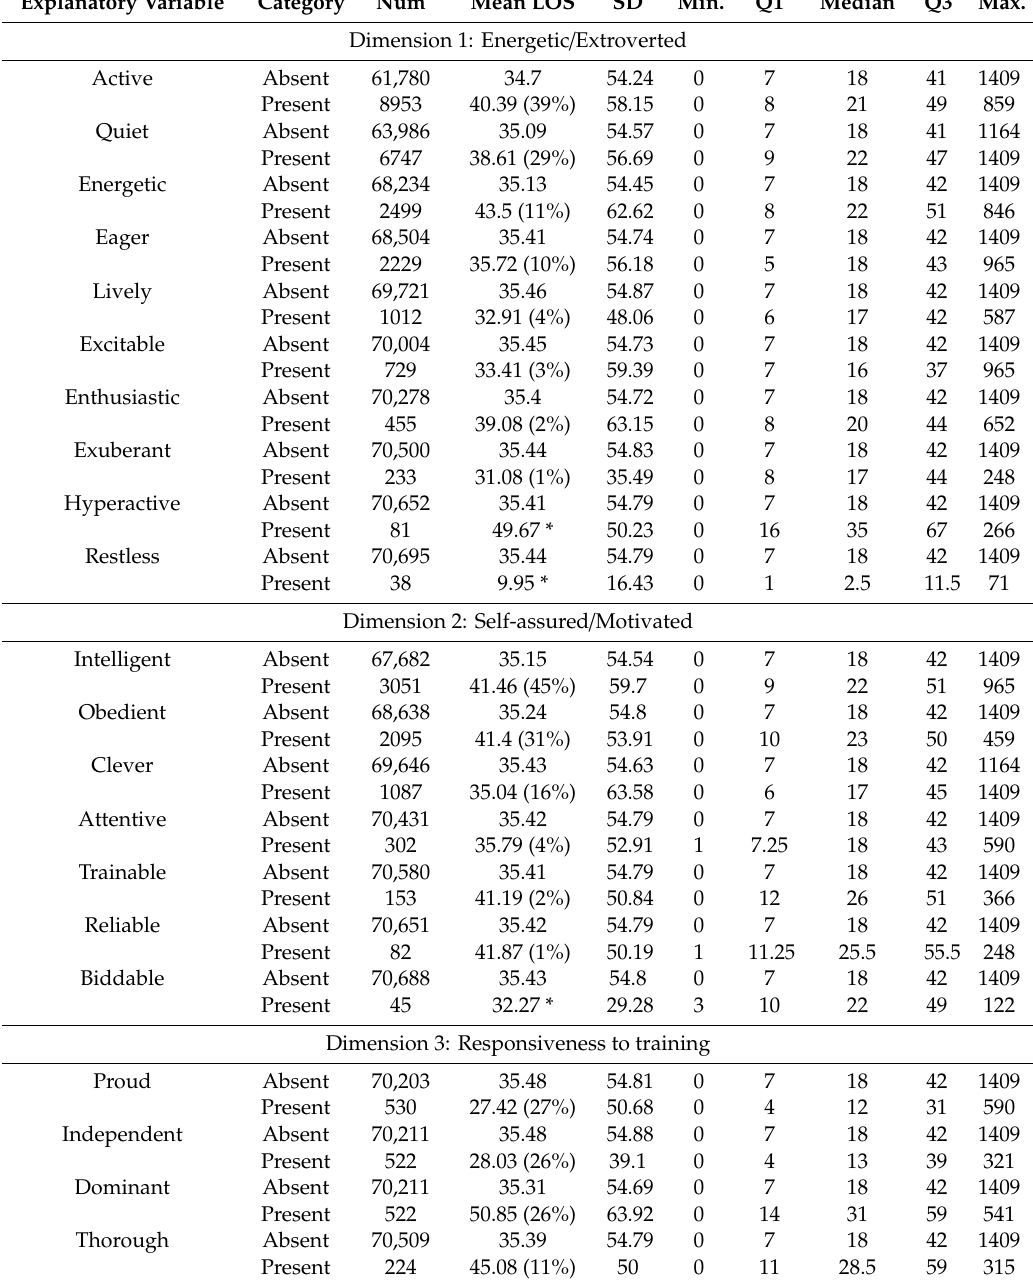
Table 2. Mean LOS (in days) per adjective and percentage representation (%) of frequency in each of five personality dimensions (comprising variables, n = 39, sourced from Ley et al., 2009) and six separate themes recurring in the current database of 70,733 dogs of all breeds. Numbers marked with (*) represent insu ffi cient data ( < 1%) due to low frequency within dimension. Percentages appear for adjectives and how commonly dimensions were represented by each of their associated